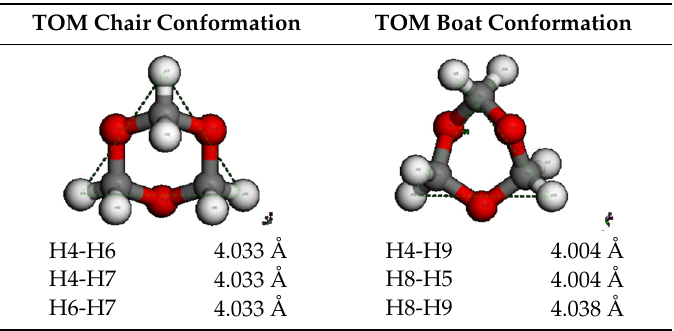
Table 3. The theoretical molecular size of TOM.